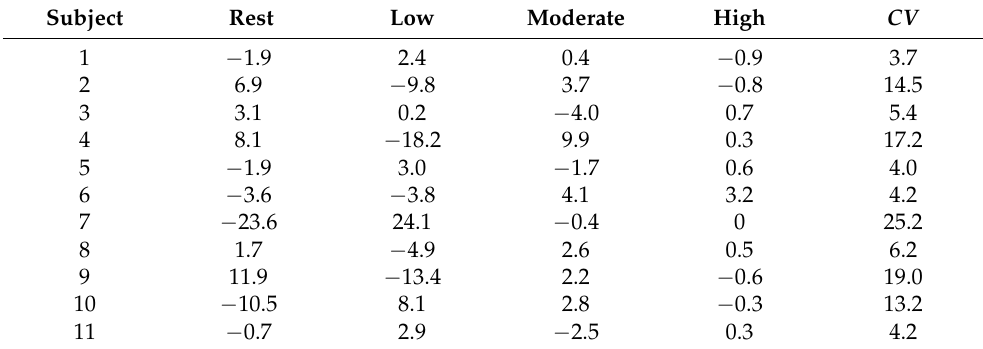
Table 4. Detection errors (in minute) per subject and per activity and corresponding coefficient of variation ( CV ) in % (with improved differentiation between Rest and Low).